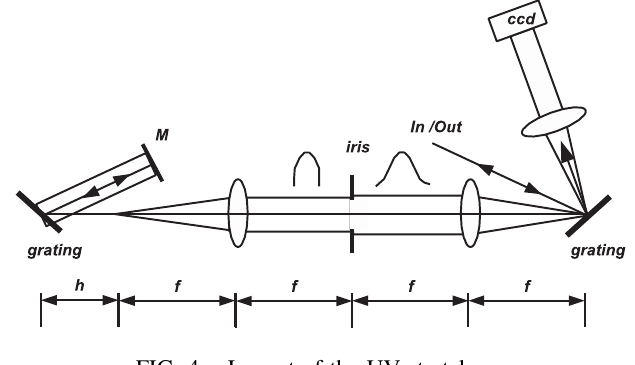
FIG. 4. Layout of the UV